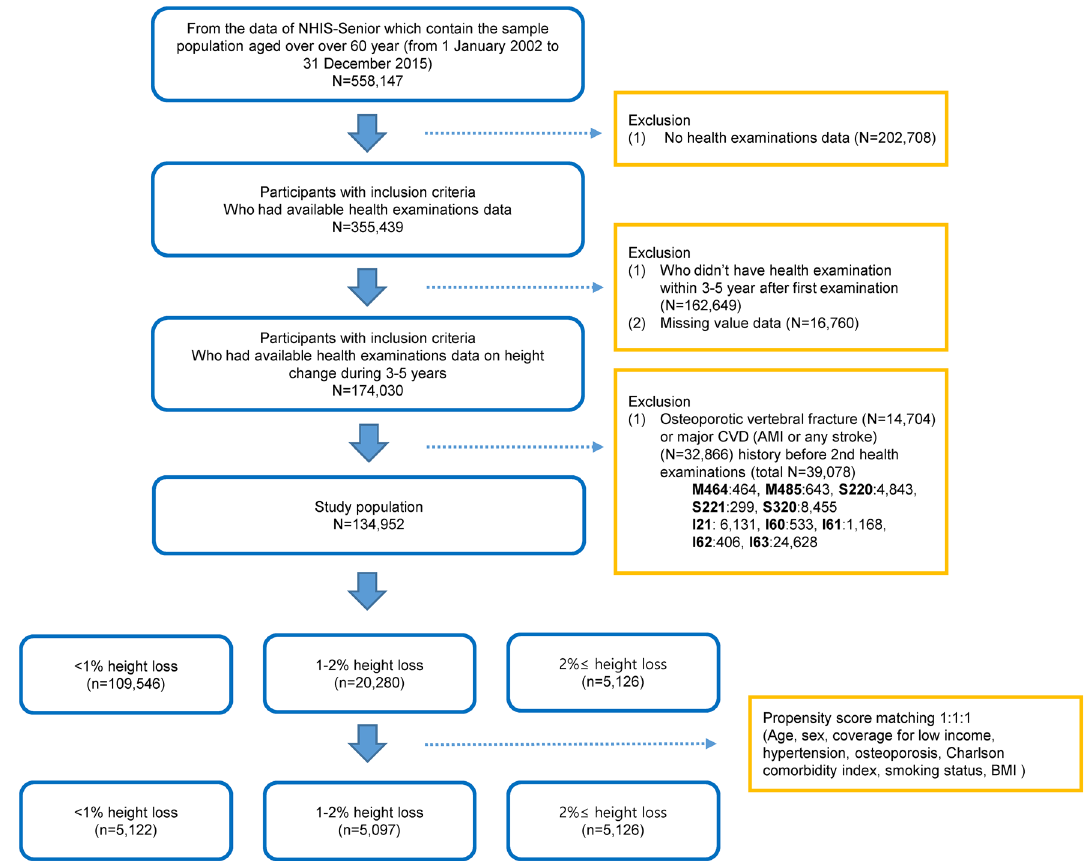
Figure 1. Flow diagram showing the selection process for participants. AMI, Acute Myocardial Infarction; BMI, body mass index; CVD, cardiovascular disease; NHIS, National Health Insurance Service. Created using PowerPoint 2016 (Microsoft Corporation, Redmond, WA,